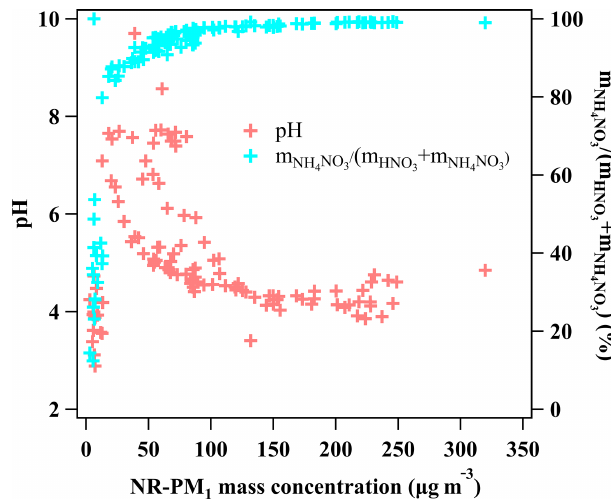
Figure 6. The pH of the fine aerosol particles (left y axis) and the molar ratio of particulate nitrate in the total nitrate (gas + particle phase; right y axis) as a function of NR-PM 1 mass